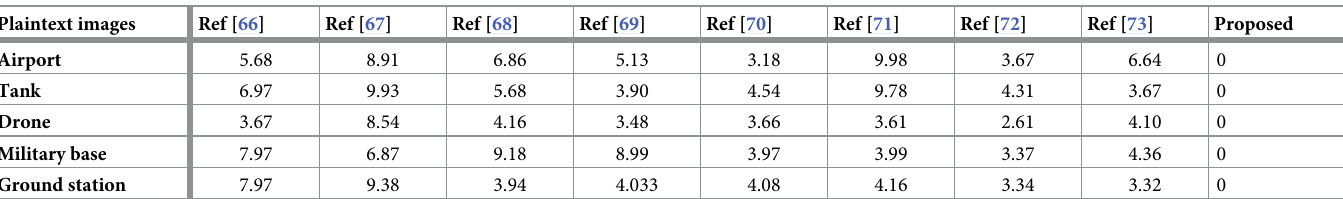
Table 11. MSE for loseless analysis.